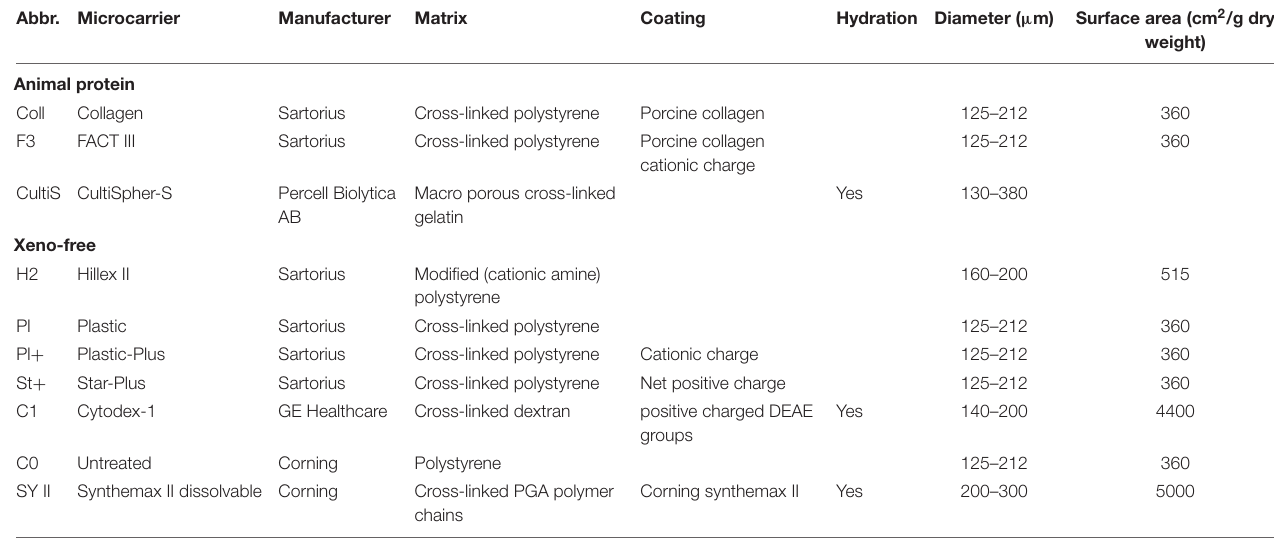
TABLE 1 | Manufacturing information of commercially available microcarriers, screened in this study. Abbr.